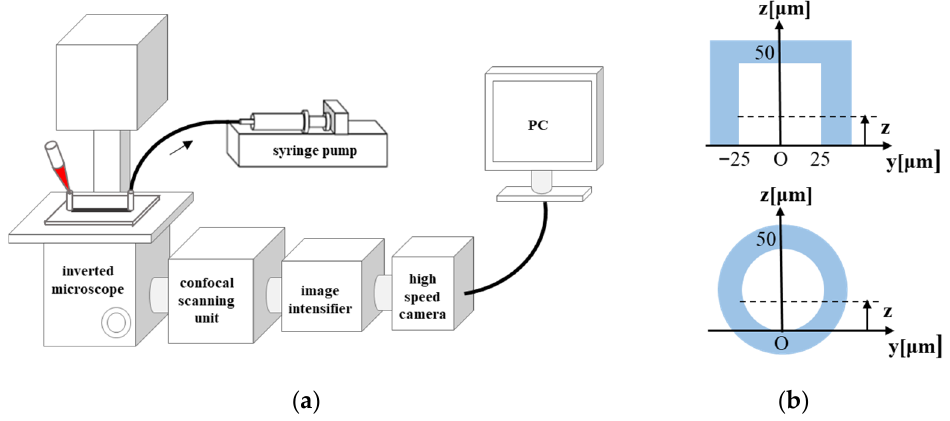
Figure 1. ( a ) Experimental setup; ( b ) cross sections of the square channel and circular channel. The circular channel is surrounded by water.